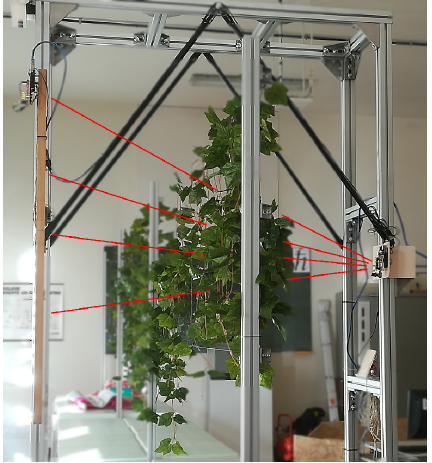
Figure 3. Detail photo of the proposed infrared barrier system.